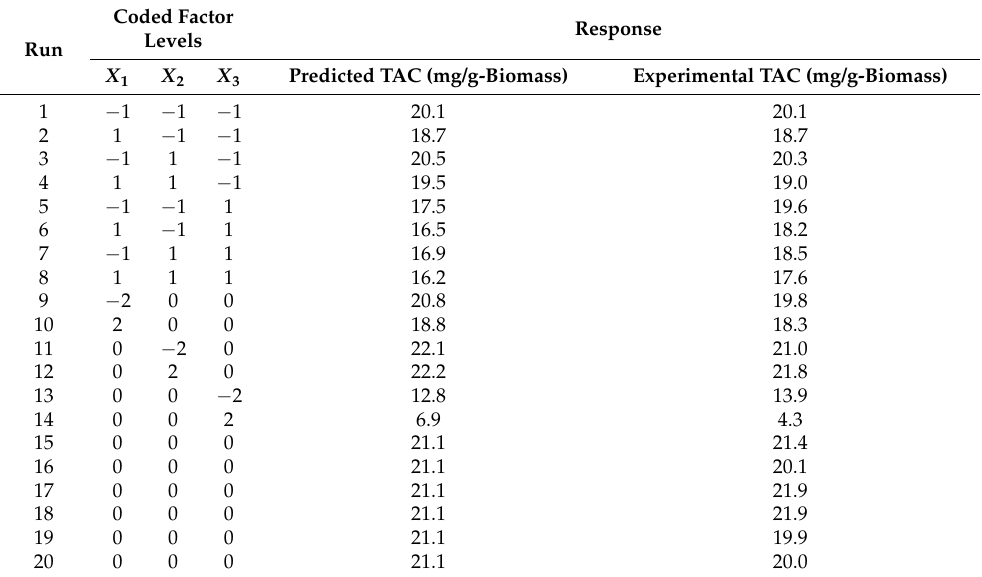
Table 2. Predicted and experimental values of anthocyanin content recovered from elderberry under the designed extraction